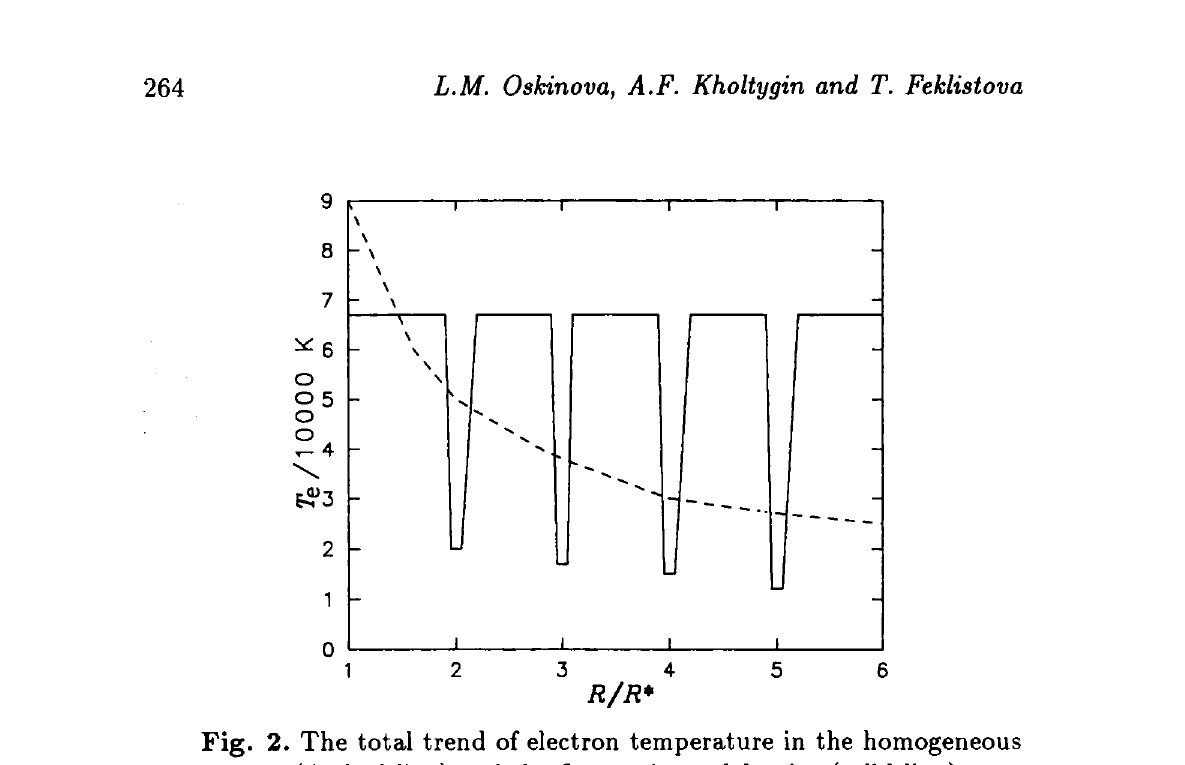
Fig. 2. The total trend of electron temperature in the homogeneous atmosphere (dashed line) and the fluctuations of density (solid